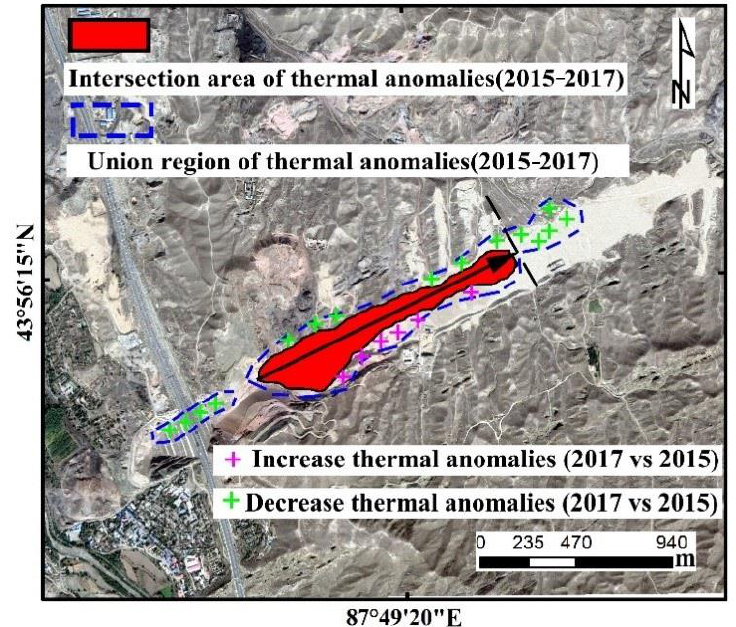
Figure 12. Spatio-temporal changes in the area of coal fires.